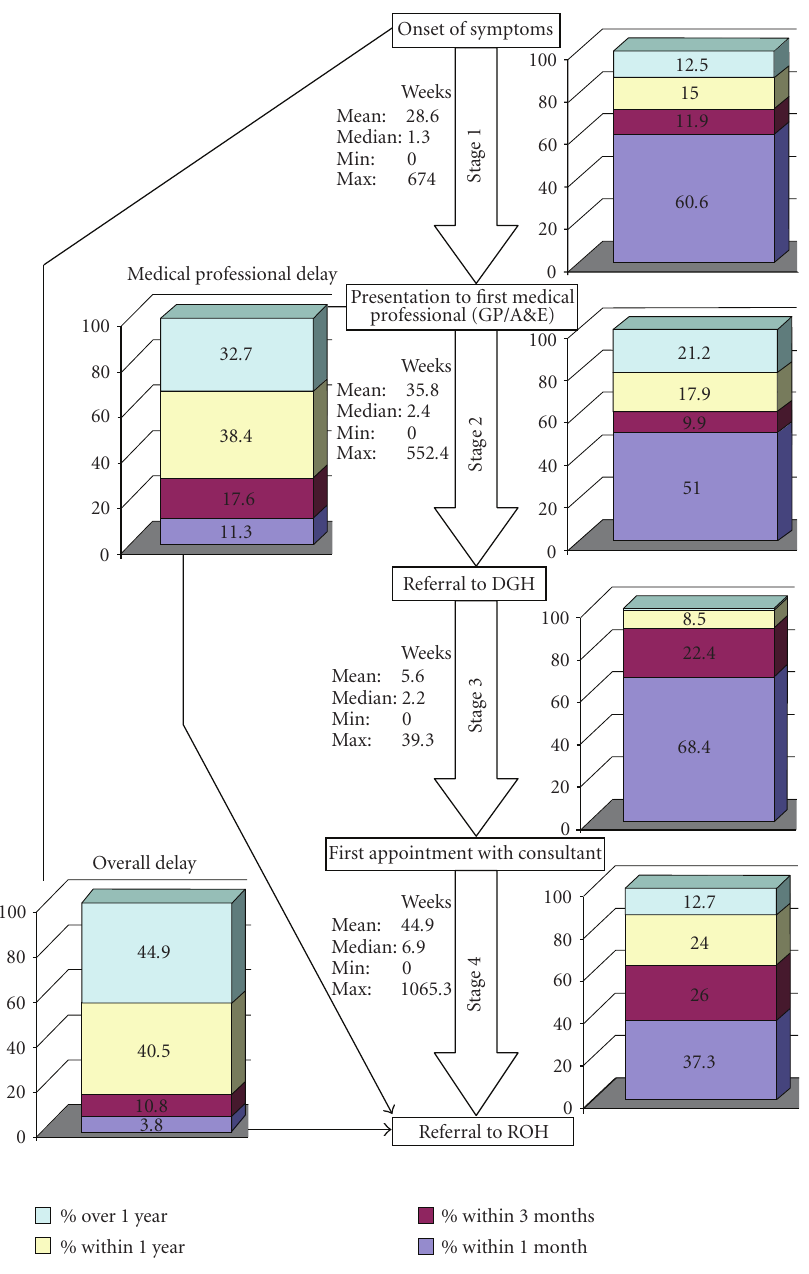
Figure 3: Flow chart of